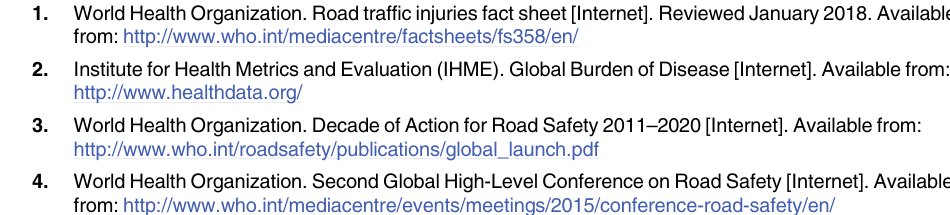
S1 Fig. Actual (solid line) and fitted (dashed line) proportion of front seat passengers wearing seat belts in the area of Florence, Italy, in